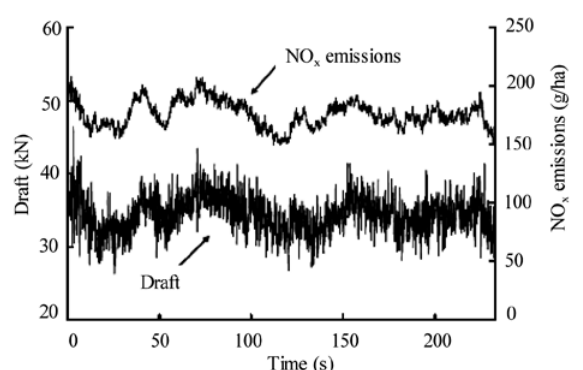
Fig. 2. Dependencies of traction force and NOx emissions and their interrelation in real-time soil preparation work (Li et al . 2006)